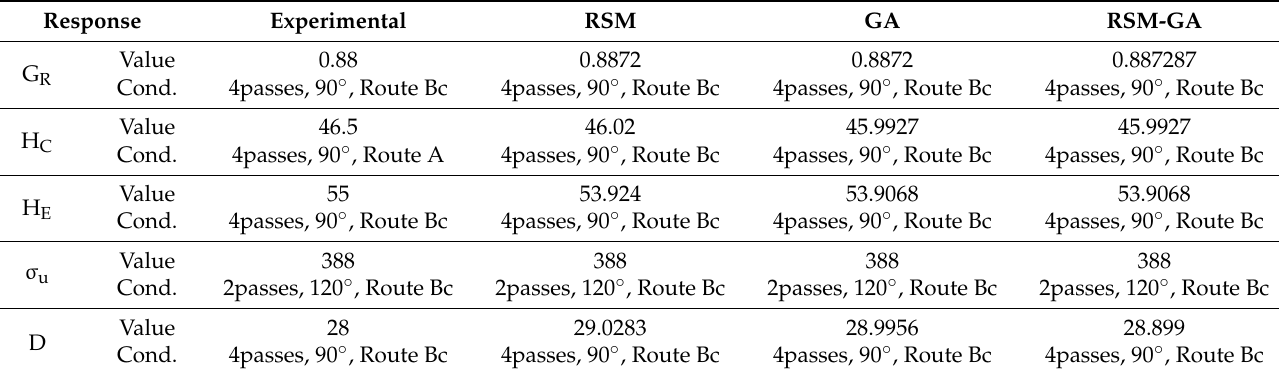
( d ) Figure 18. Optimum σ u ( a , b ), and D ( c , d ) by GA ( a , c ), and hybrid RSM-GA ( b , d ).